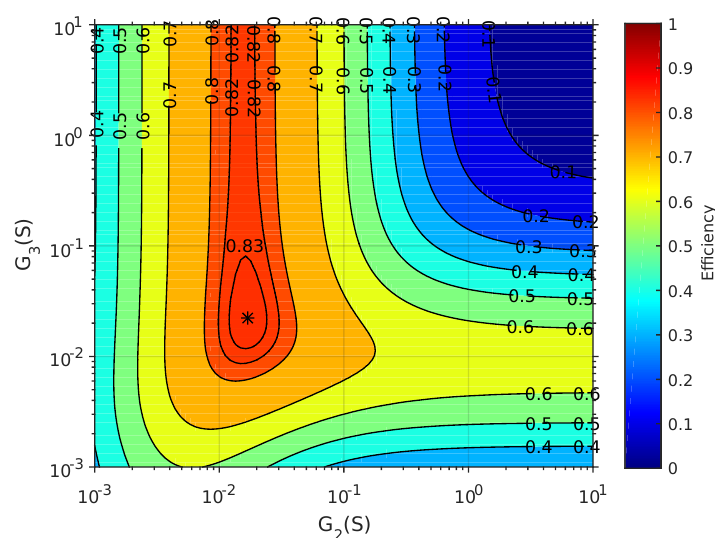
Figure 5. The efficiency η as a function of the load conductances G 2 and G 3 for the capacitive wireless power transfer (CWPT) system with one transmitter and two receivers of Table 2. The asterisk indicates the location of the maximum efficiency of